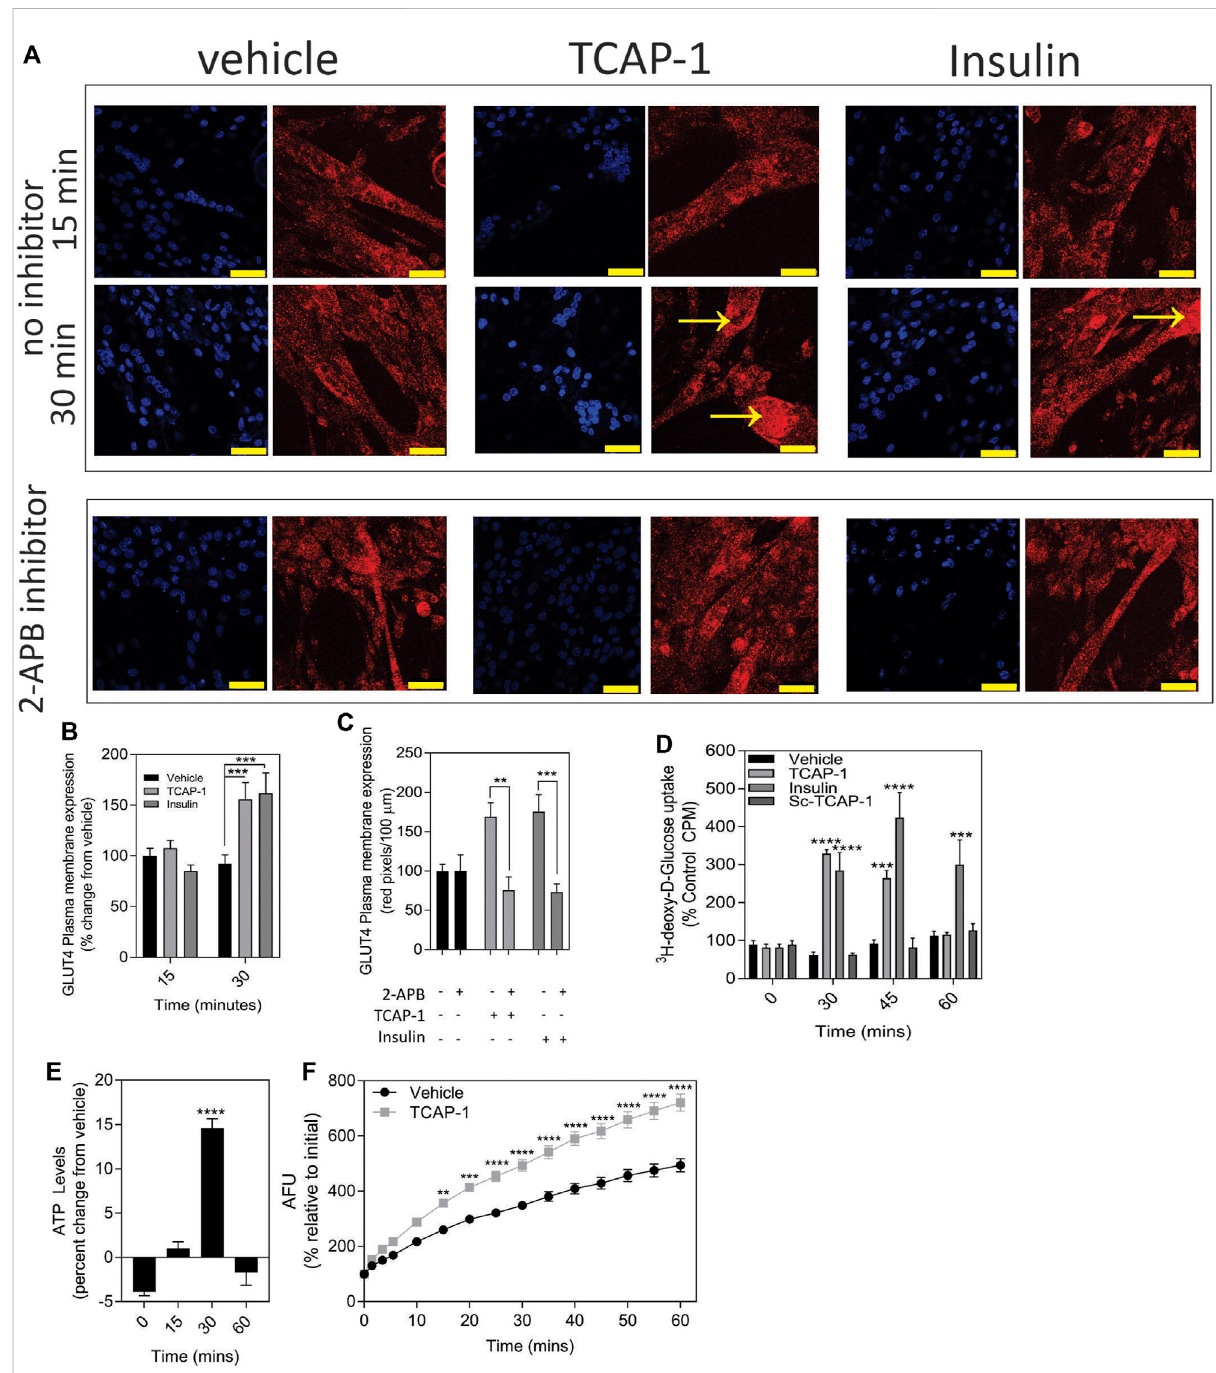
FIGURE 8 TCAP-mediated glucose metabolism in C2C12 cells. (A) . Regulation of ir-GLUT4 by TCAP-1 and insulin myotubules. Red indicates ir-GLUT4 whereas blue shows DAPI staining of the nuclei. Arrows indicated regions of high immunoreactivity. Scale bar = 100 µM. (B) . Quanti fi cation of ir- GLUT4 expression over 30 min. (C) . Effect of the IP3R inhibitor, 2-APB on TCAP-1- and insulin-mediated ir-GLUT4 labelling. (D) . Uptake of 3 H-2- deoxyglucose in C2C12 myoblasts by TCAP-1 and insulin. (E) . Changes in static ATP concentrations following treatment by TCAP-1. (F) .